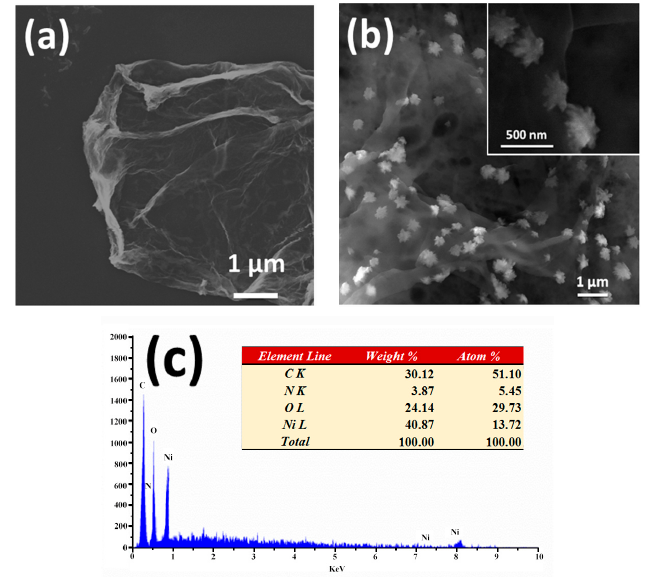
Figure 1. ( a ) FESEM morphologies of GO; and ( b ) Ni/NiO-rGO; and ( c ) surface EDS spectrum of Ni/NiO-rGO.